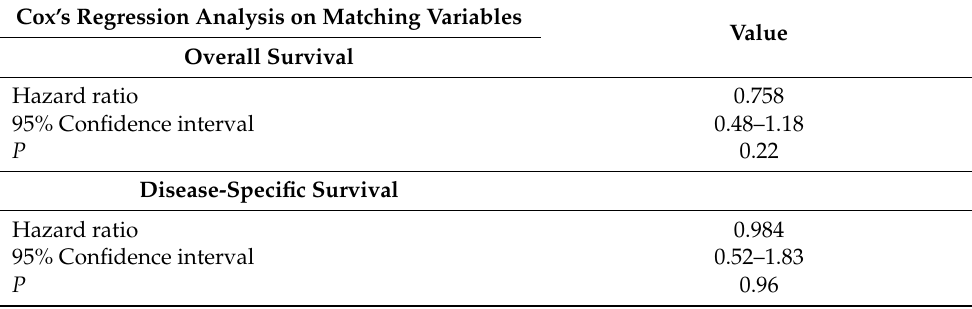
Table 3. Hazard ratios for event rate associated with